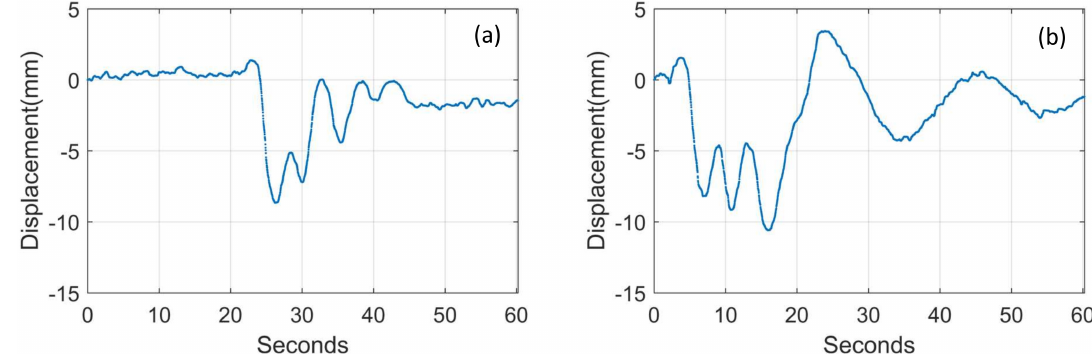
Figure 15. Vertical displacement time series induce by a high-speed train ( a ) and a metro ( b ) in the middle of the 192-m-span monitored using